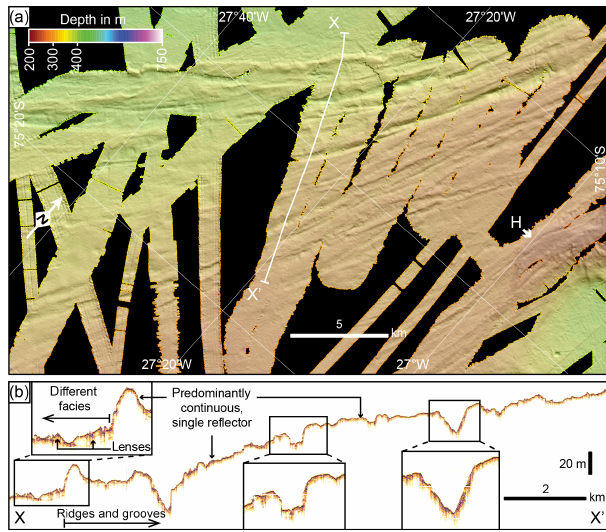
Figure 7. High-resolution bathymetric map (a) from the western slope of McDonald Bank showing curvilinear ridges and grooves of Class I that are interpreted as ice marginal landforms. The short bold arrow marks the front of the westernmost Class H ramp. The sub- bottom profile (b) displays the depths of the groove incisions, the lack of penetration of the acoustic signal, and a different acoustic facies northwest of the ridges and